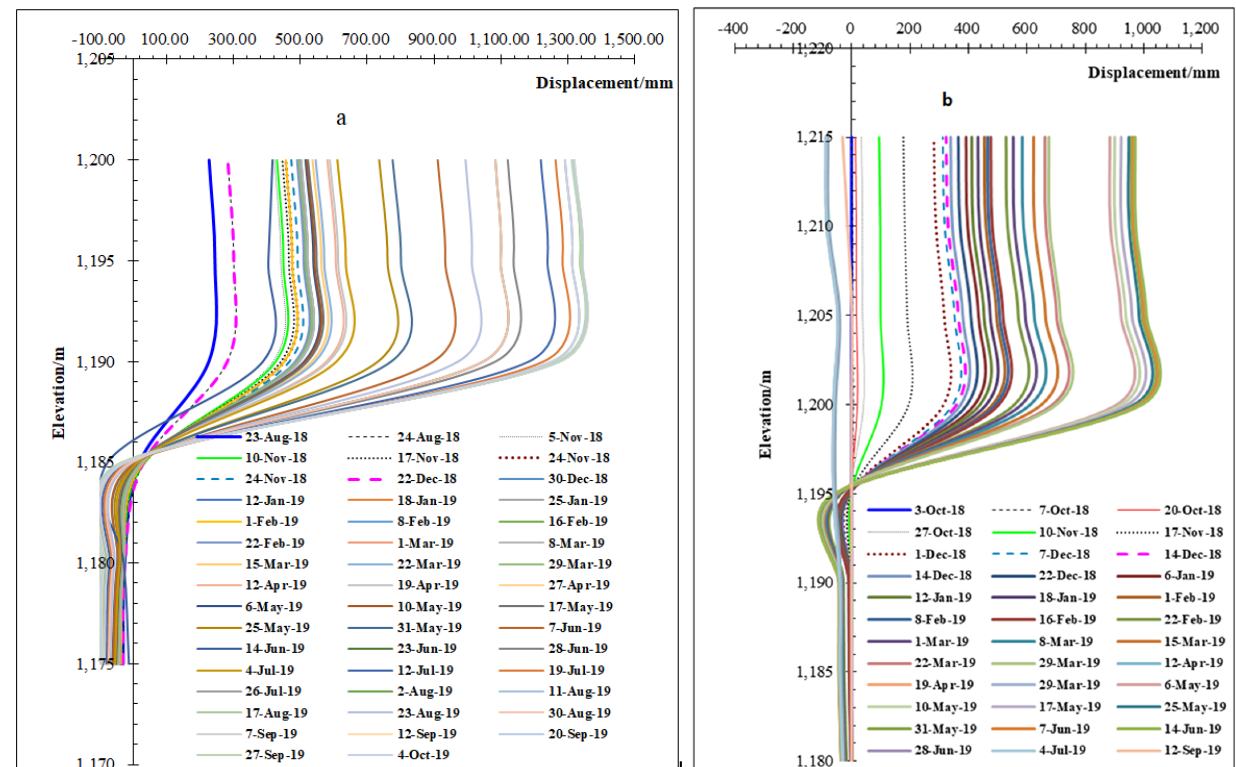
Figure 7. Process curve of deep displacement fixed inclinometers: ( a ) Monitor station CX03 and ( b ) Monitor station CX01.